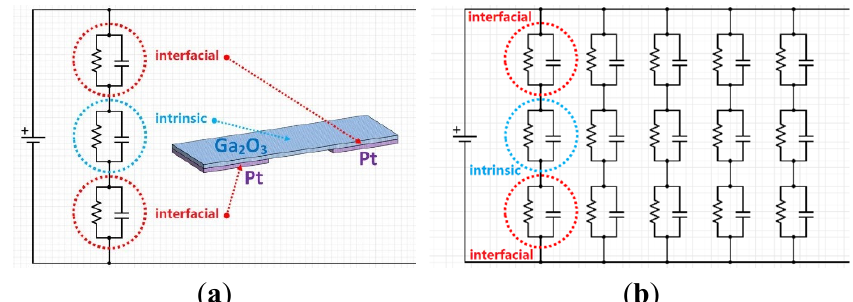
Figure 3. ( a ) Origin of capacitors of the individual Ga 2 O 3 nanobelt on Pt IDEs and ( b ) the circuit model of the individual Ga 2 O 3 nanobelt on Pt IDEs.